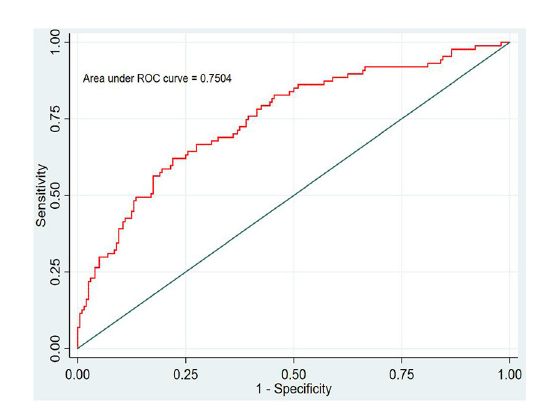
FIGURE4 External verification set.